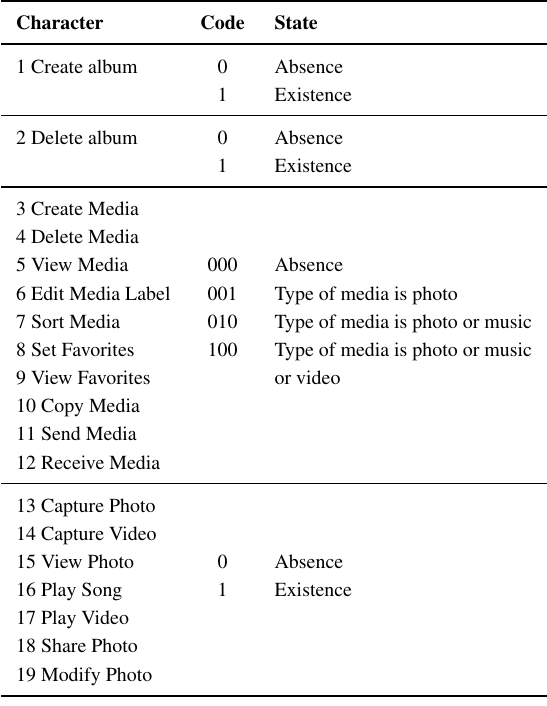
Table 2. Characters of the population and their